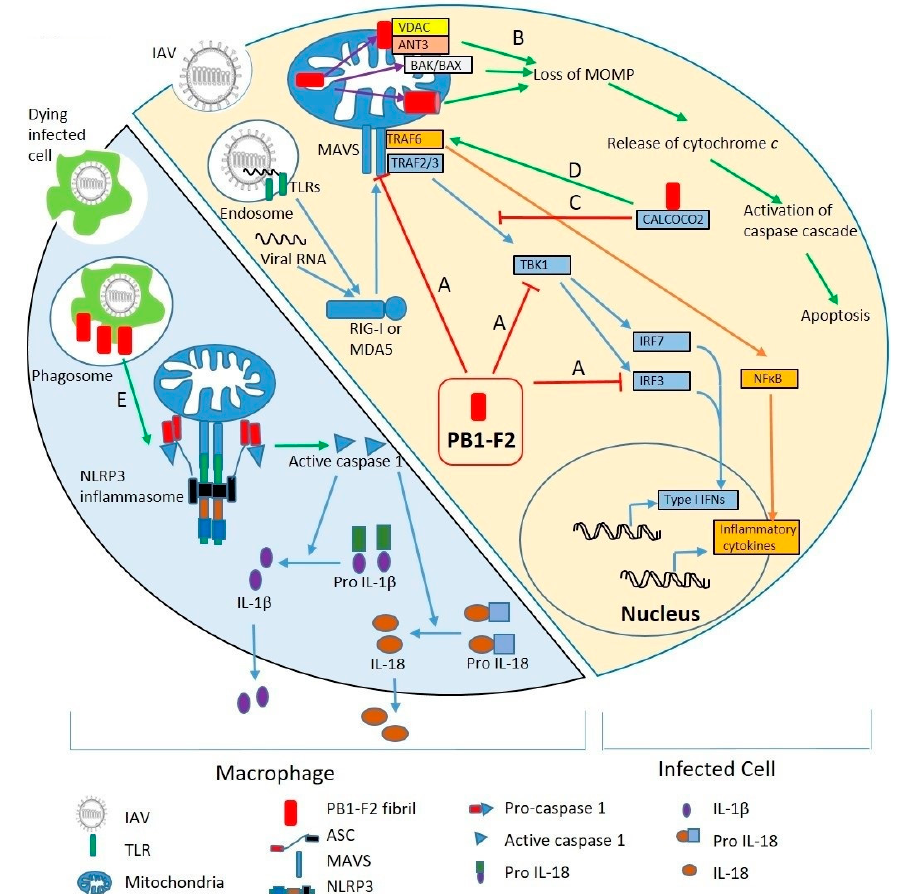
Figure 3. Molecular mechanisms of PB1-F2 virulence. Right side of the diagram shows an IAV infected cell; left side shows a macrophage phagocytosing virus-infected cells. ( Right ) Upon IAV infection, viral RNA is discovered by TLRs in endosomes and RIG-I and MDA5 in the cytosol. RIG-I and/or MDA5 triggers MAVS-mediated activation of the innate immune response. MAVS recruits TRAF3 and TRAF6. TRAF3 leads to production of Type I IFNs through IRF3 and IRF7 pathways. TRAF6, through NF- κ B, stimulates expression of inflammatory cytokines. PB1-F2 inhibits type I IFNs by interfering with MAVS, TBK1 and IRF3 (A). PB1-F2 localized to mitochondria leads to loss of mitochondrial outer membrane potential (MOMP) (B) either by binding to mitochondrial membrane proteins VDAC and ANT3, activation of BAK/BAX, or pore forming through PB1-F2 oligomerization. MOMP loss releases cytochrome c into the cytosol, activates caspase cascades, and leads to apoptosis. By binding to CALCOCO2 (C), PB1-F2 inhibits IFN signaling pathway, but also stimulates TRAF6-mediated NF- κ B activation, thus promoting inflammatory cytokine production (D). ( Left ) PB1-F2 stimulates NLRP3 inflammasomes in macrophages upon phagocytosis of virus-infected dead cells (E). Inflammasome activation leads to maturation and release of IL-1 β and IL-18.